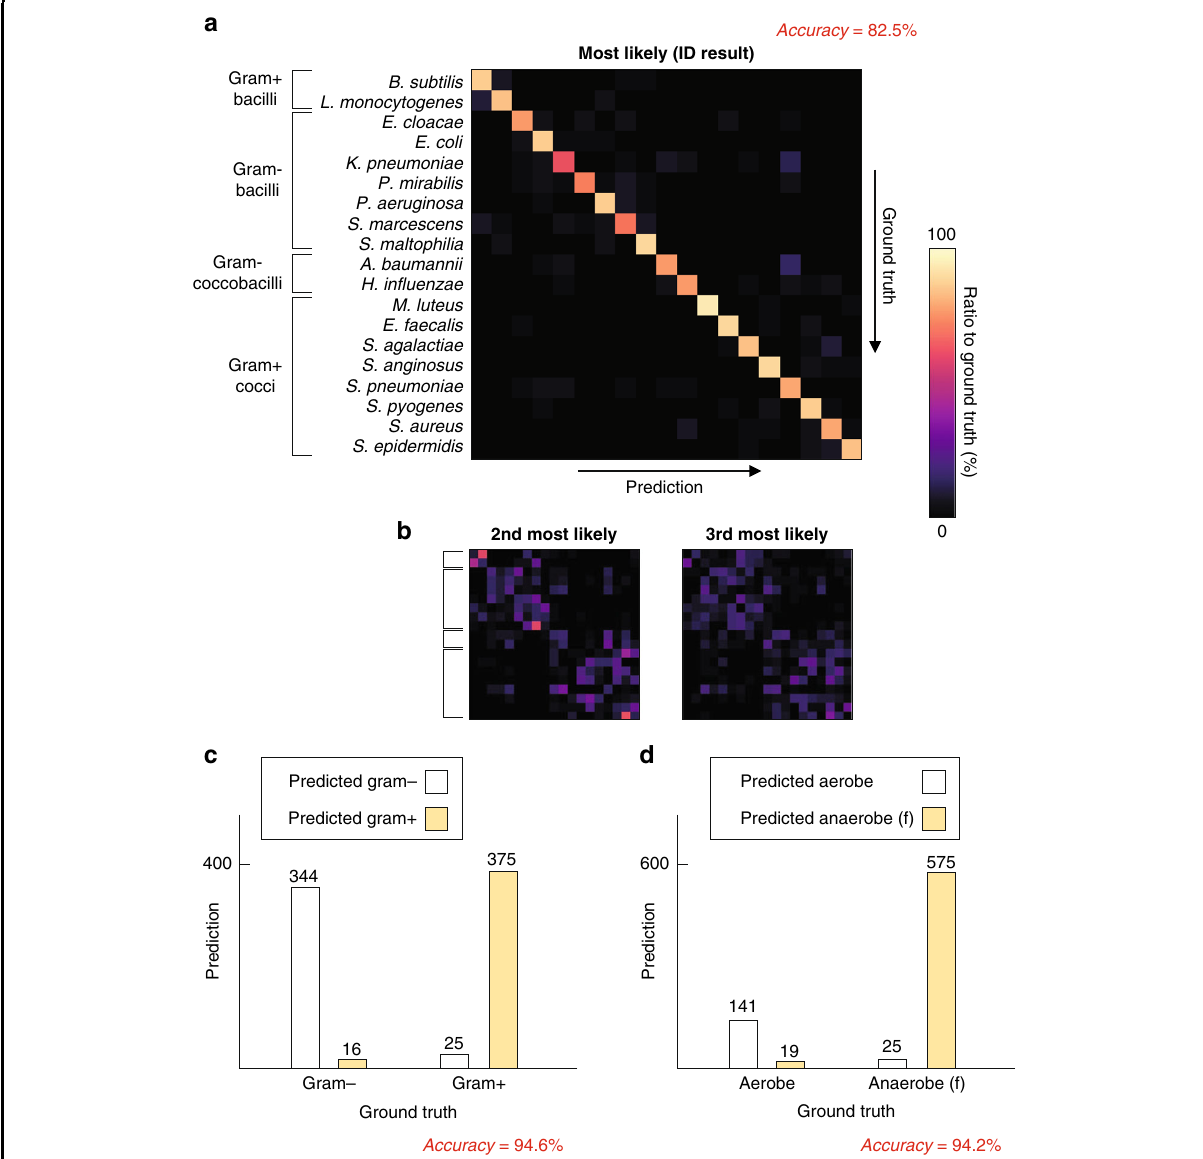
Fig. 5 Distribution of error in the species identi fi cation using a single 3D RI tomogram. a The confusion matrix visualizes the overall performance and the frequent errors in the blind test dataset. The row and column indices correspond to the ground truth and the prediction, respectively. The indices of the 19 species are ordered to re fl ect the common bacterial categories. b The distribution of the second and the third most likely species further visualizes the interspeci fi c similarity recognized by the trained ANN. c , d Individual tomograms are categorized under broader groups including gram-stainability and respiratory metabolism using a modi fi ed ANN for each